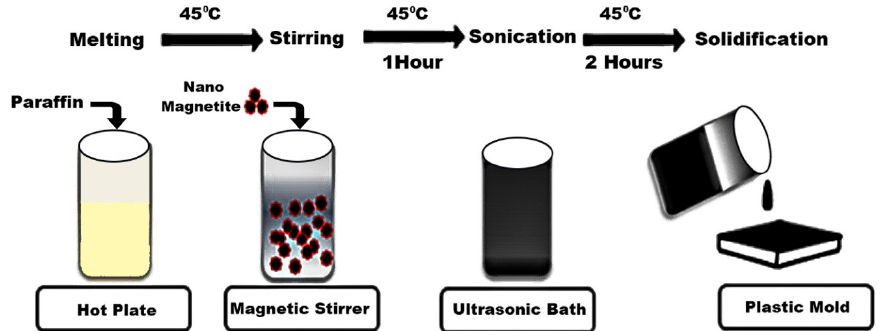
Figure 3. Steps of preparation of paraffin/graphene oxide.